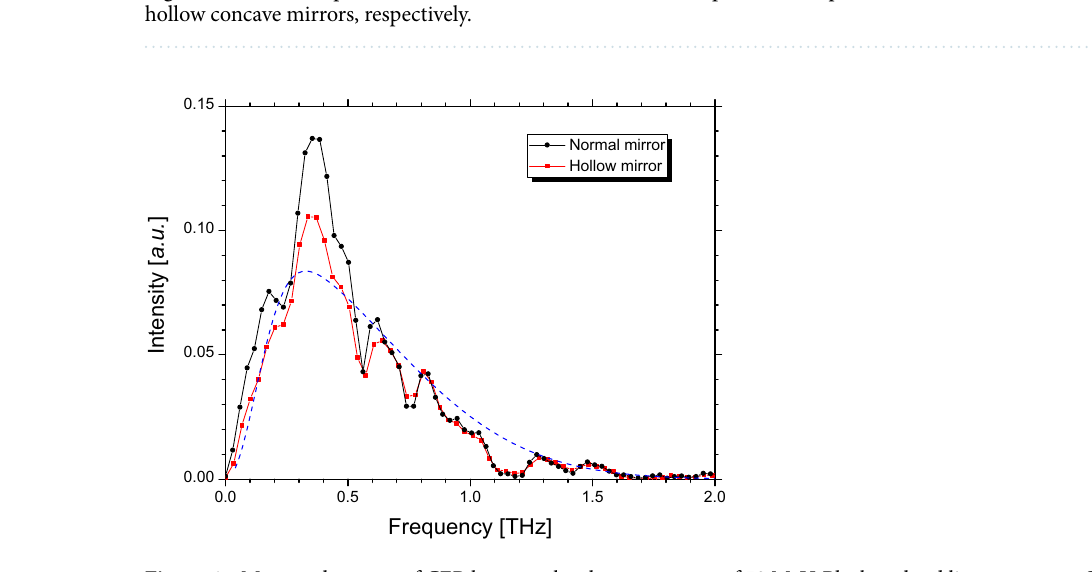
Figure 4. Measured spectra of CER beam at the electron energy of 58 MeV. Black and red lines represent CER power measured with normal and hollow concave mirrors, respectively. Dotted blue line represents fitting curve for spectrum measured using hollow concave